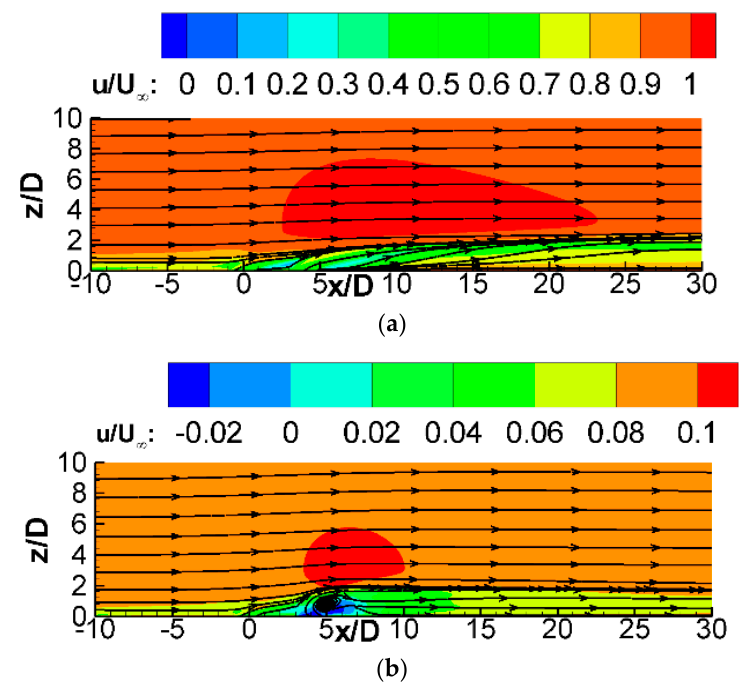
Figure 6. Time-averaged x -velocity contour of mid-span plane in ( a ) Case 1 and ( b ) Case